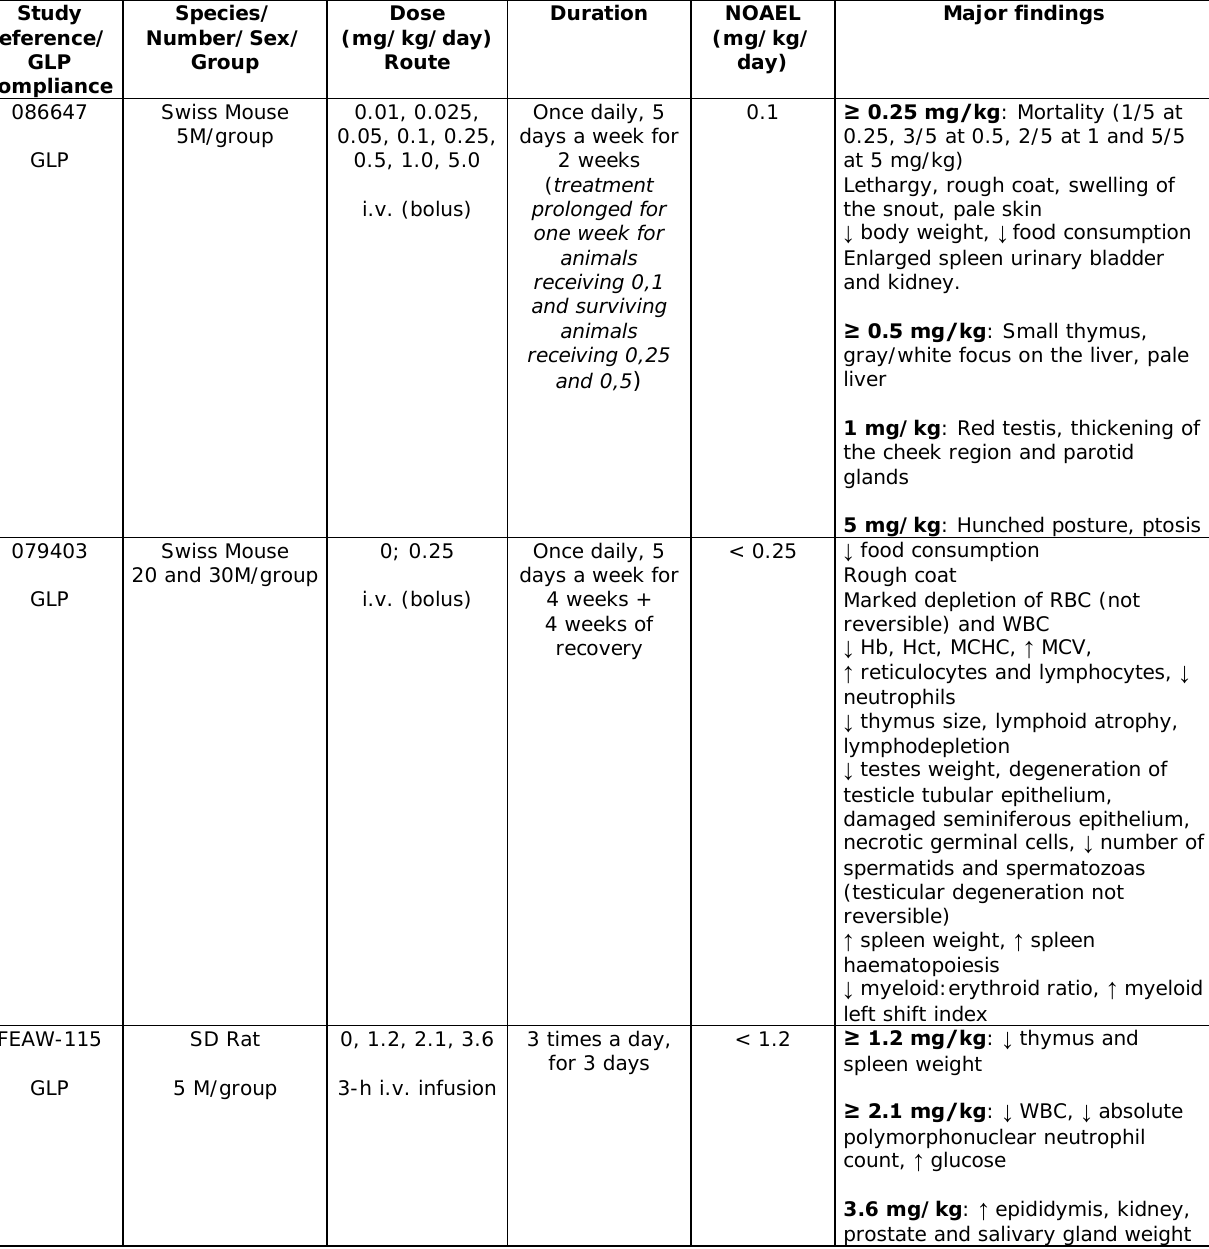
Table 6: Summary of repeat-dose toxicity studies Study